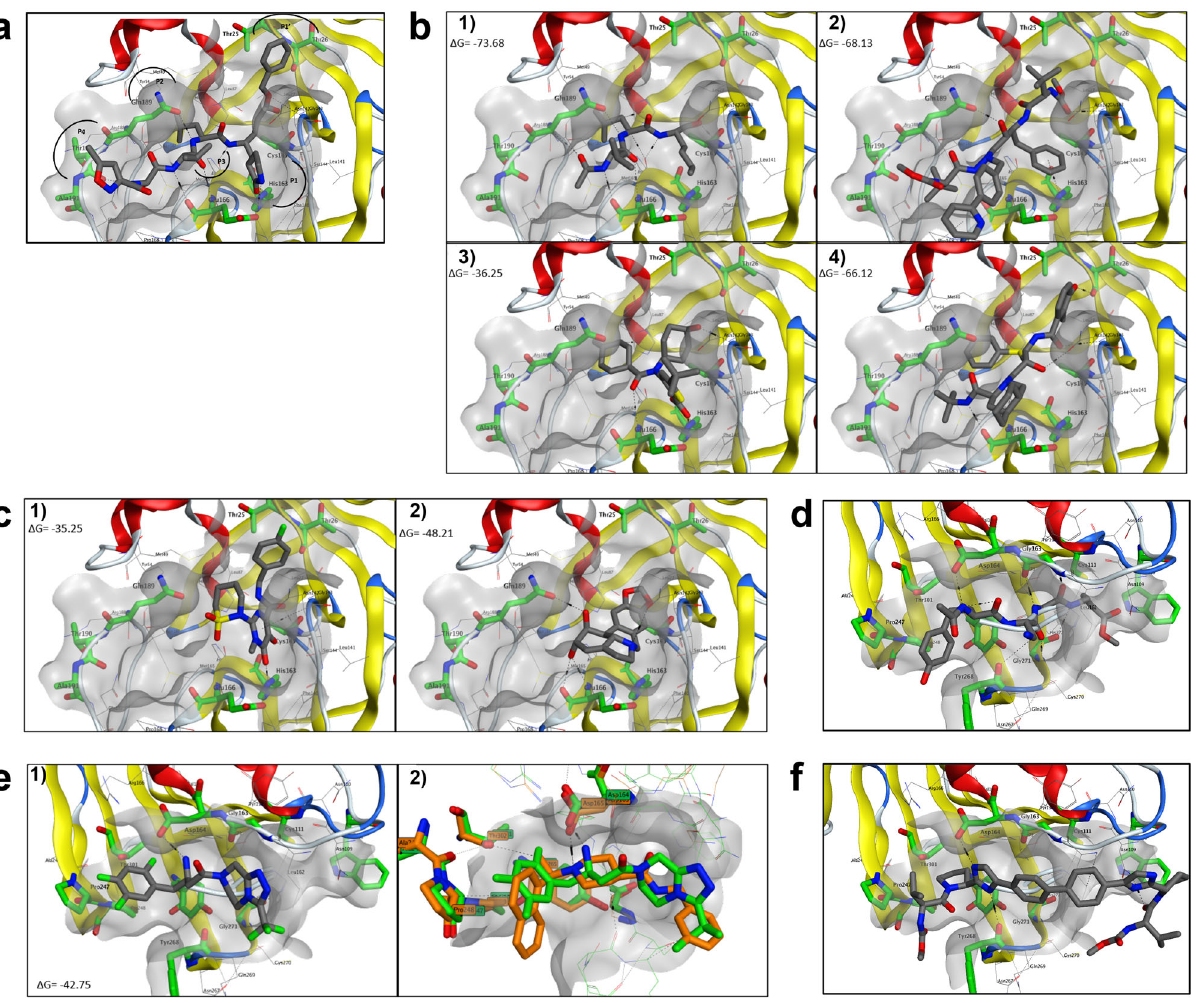
Fig. 7 Docking of SARS-CoV-2 inhibitors. The key residues forming the binding pocket are highlighted in green. H-bonds are depicted as dashed black lines. a Co-crystallographic pose of peptidomimetic inhibitor N3 (PDB 7BQY) in the active site of SARS-CoV-2 Mpro. b Predicted binding mode for (1) MG- 101, (2) Atazanavir, (3) Lomibuvir, and (4) Nel fi navir in the Mpro- active site. c Predicted binding mode for (1) BMS-707035, and (2) Lycorine HCl in the Mpro- active site. d Co-crystallographic poses of VIR251 (PDB 6WX4) in the active site of SARS ‐ CoV-2 PLpro. e (1) Predicted binding mode for Sitagliptin in the PLpro-active site, (2) Superposition of SARS-CoV crystal structure (4OW0, orange) and SARS-CoV-2 crystal structure (PDB 6WX4, green) the docked Sitagliptin. f Predicted binding mode for Daclatasvir in the PLpro- active